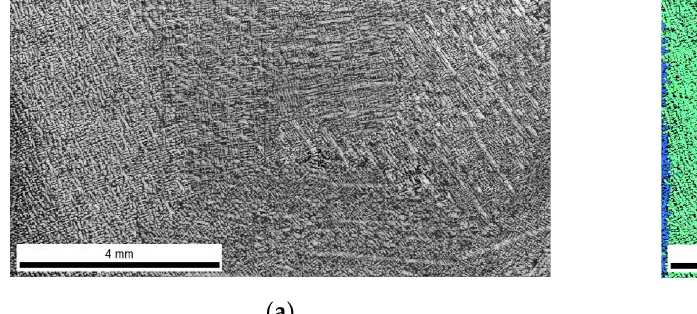
Figure 7. Structure of chromium cast iron in a 30 mm thick plate. ( a ) light microscope; ( b ) EBSD.